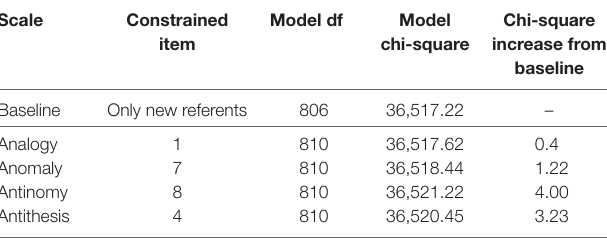
New referents for this analysis were Analogy 2, Anomaly 4, Antinomy 2, Antithesis 6.